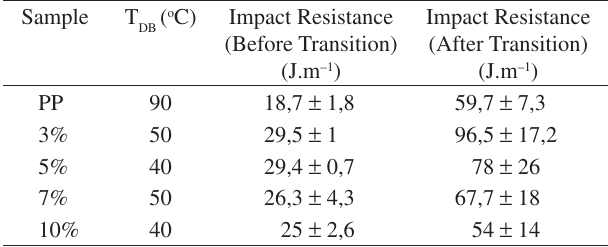
Table 2. Brittle-to-ductile transition temperature and impact resistance before and after